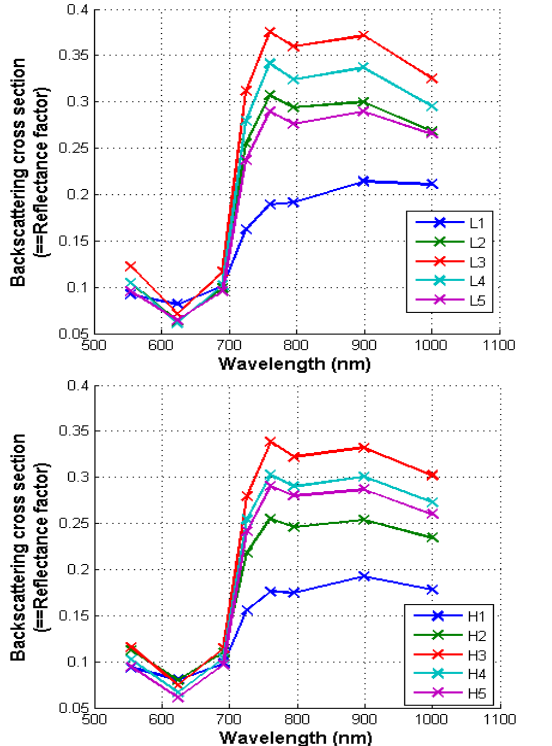
Figure 2 Average reflectance spectra of the nadir scanned oat samples. L indicating low and H high seeding density and the numbers from one to five indicate fertilization level with five being the highest fertilization